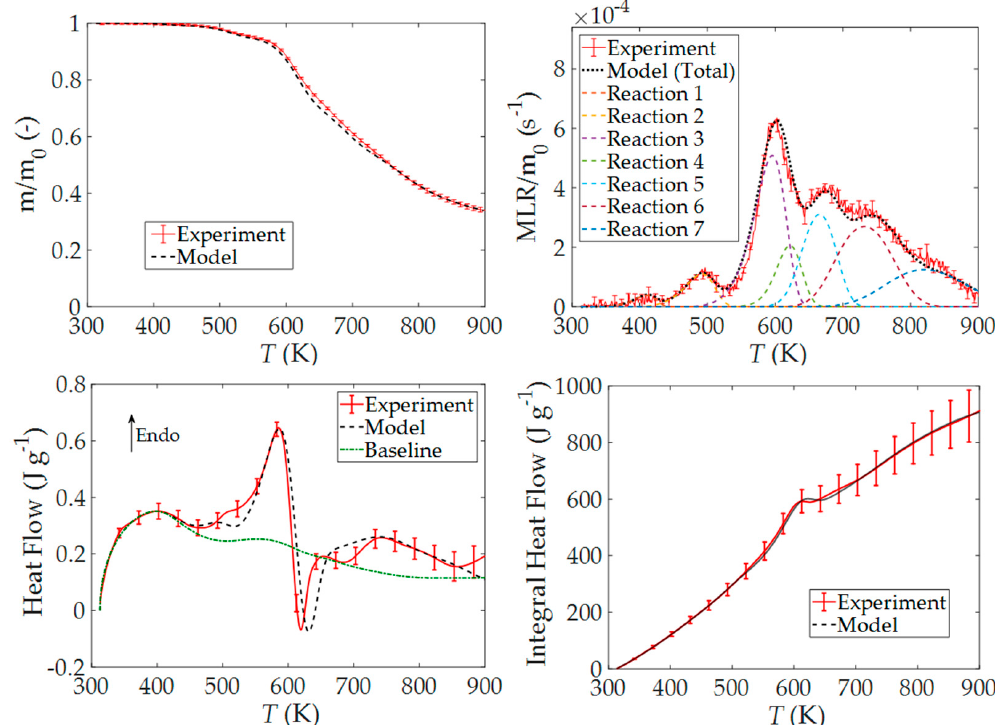
Figure 3. Mean experimental results and model predictions for the thermogravimetric analysis (TGA) and differential scanning calorimetry (DSC) tests performed on the PIR foam at 10 K min − 1 in nitrogen.